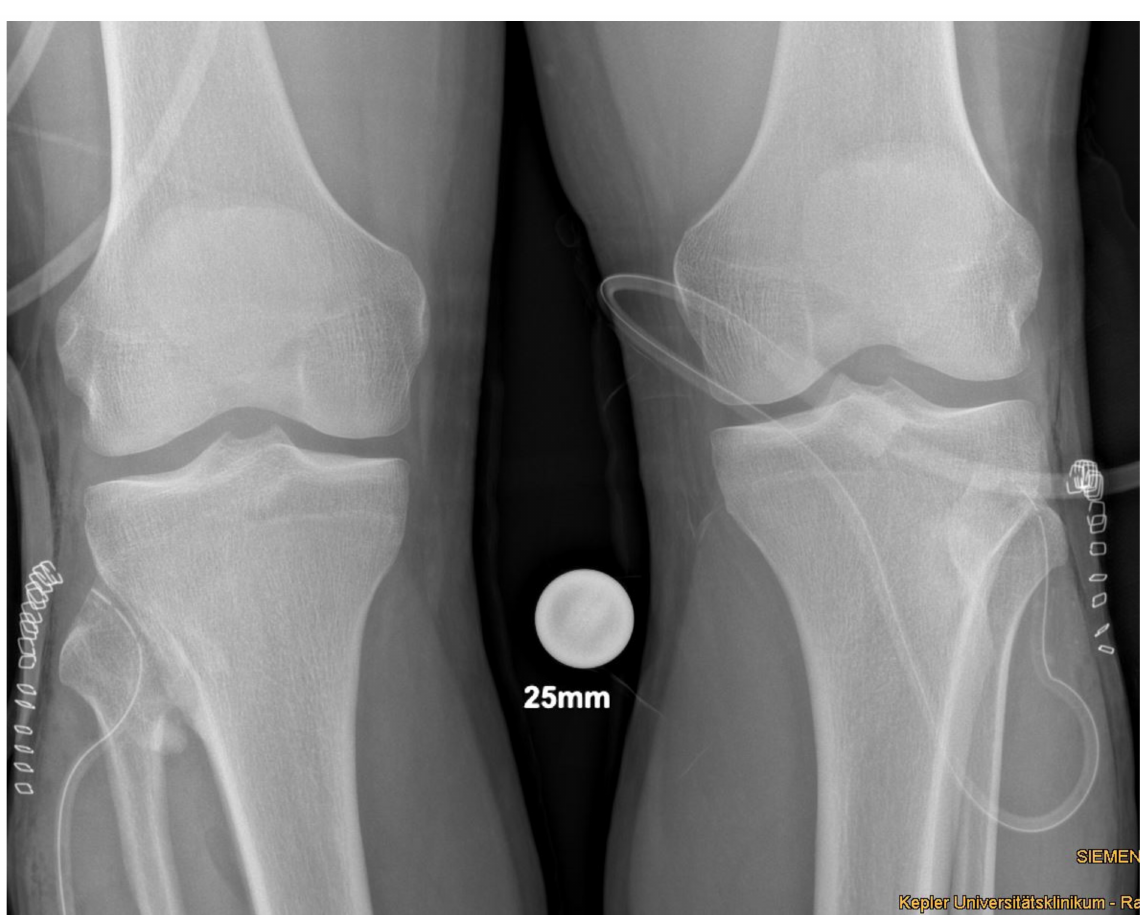
Figure 5. Plain radiograph in a.-p. view after